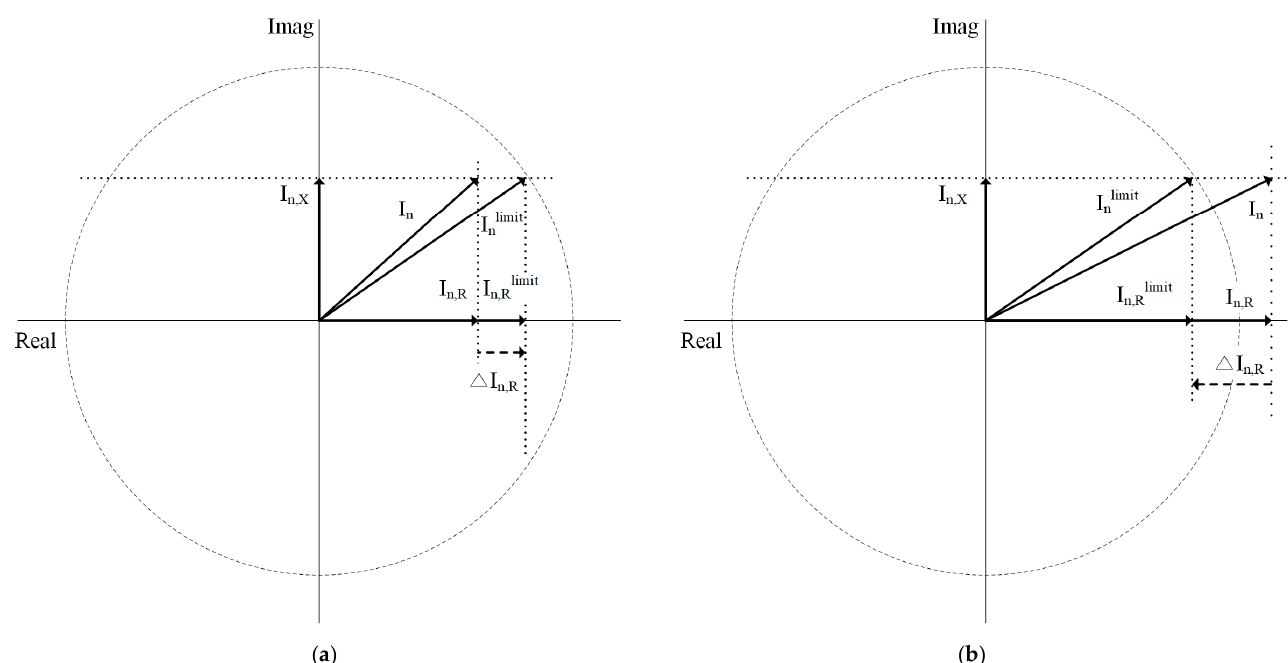
Figure 11. Vector diagram for ∆ I n , R , the difference between the current in the representative section and the maximum current limit: ( a ) ∆ I n , R when I n is within the limit; ( b ) ∆ I n , R when I n exceeds the